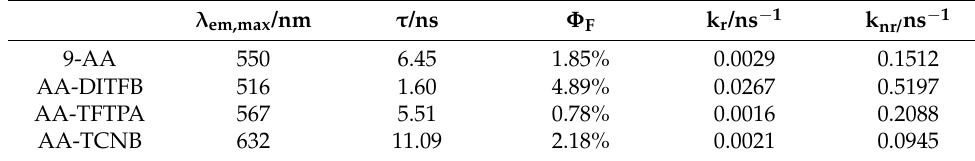
Table 1. Photophysical parameters of 9-AA and the resulting cocrystals.